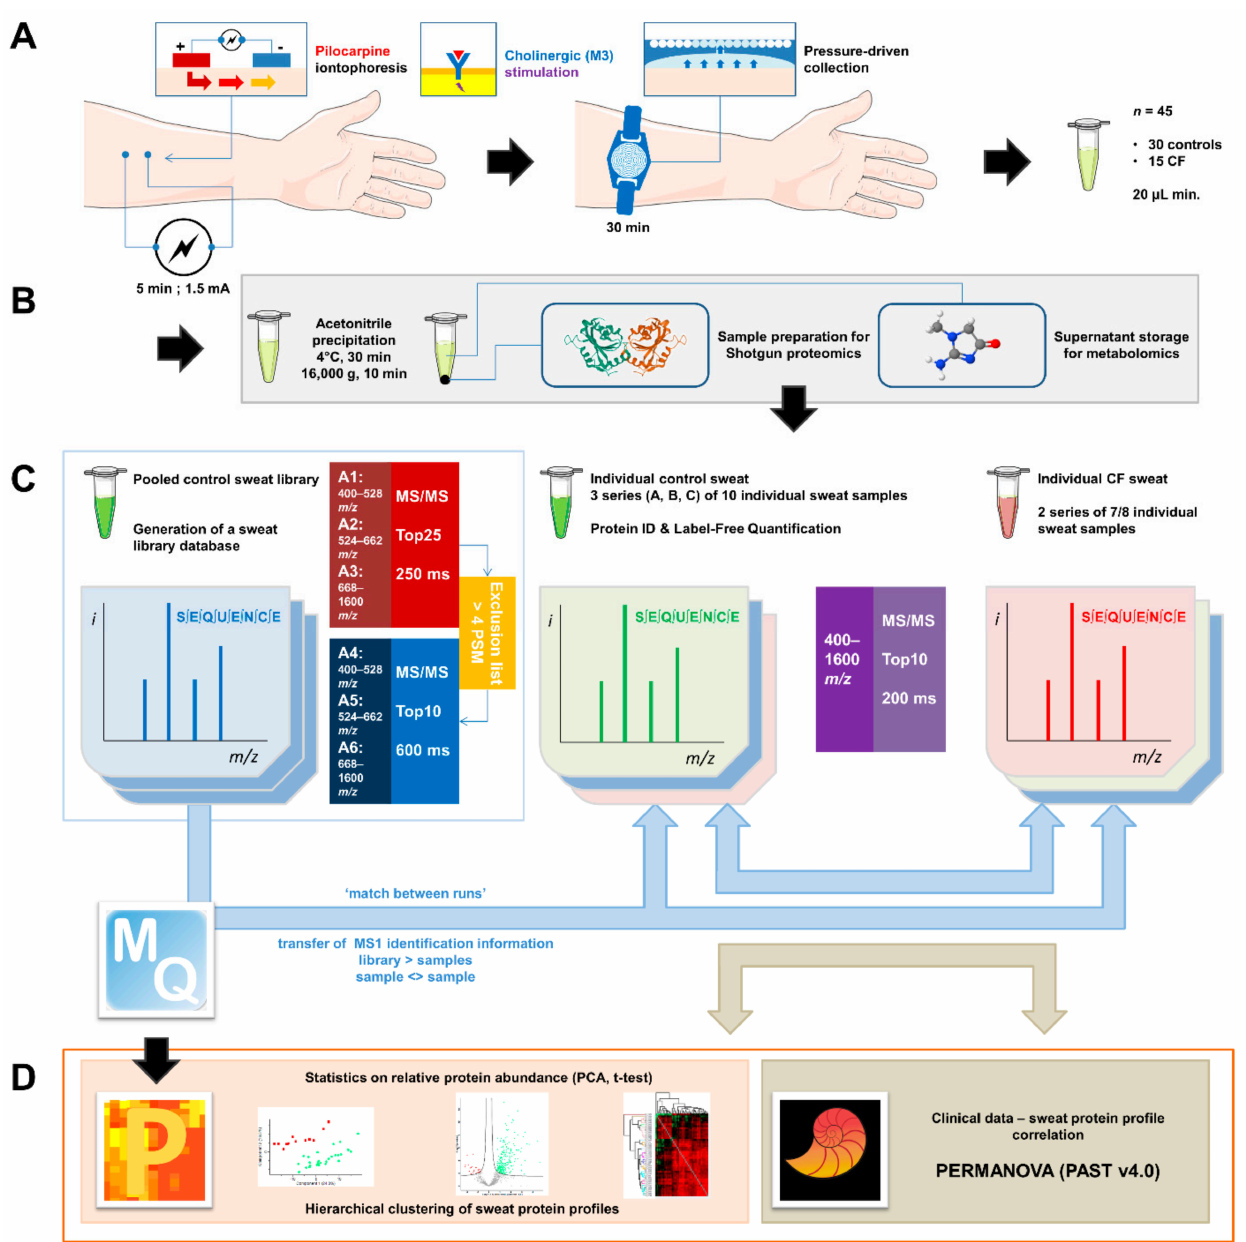
Figure 1. General experimental workflow. ( A ) Standardized sweat collection method. ( B ) Single sample preparation method for subsequent sweat proteomics and metabolomics studies. ( C ) Analyti- cal and bioinformatic strategy using the “match between runs” option (MaxQuant). 1. Generation of a sweat reference proteome database from pooled control samples. A two-round analysis of three limited m / z range acquisitions was performed. A precursor exclusion list was applied for the second-round experiment. 2. Individual sweat sample analyses. ( D ) Statistical data processing